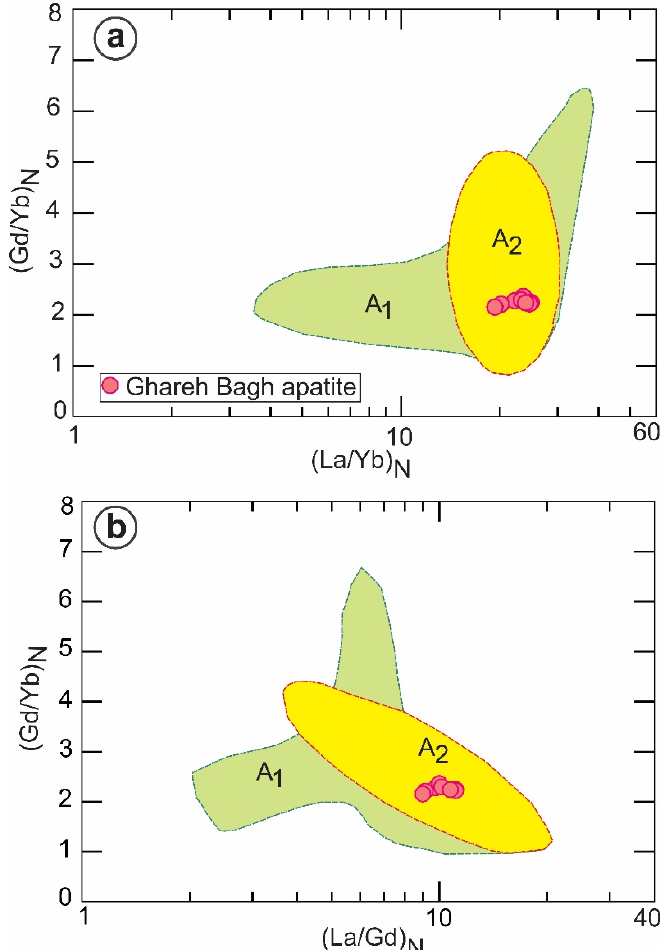
Figure 9. ( a , b ) Biplots of (Gd / Yb) N vs. (La / Yd) N and (Gd / Yb) N vs. (La / Gd) N for A-type granite. Data of apatite from A 1 (greenfield) and A 2 (yellow field) from Jiang et al. [48]. Apatite in Ghareh Bagh plot in A 2 filed.